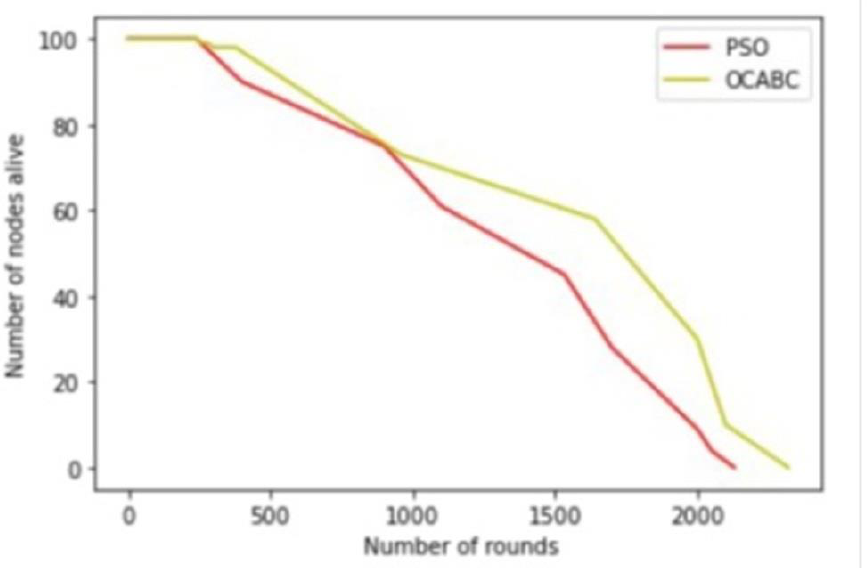
Figure 9. Number of rounds vs. number of nodes alive using the PSO and OCAB algorithms .